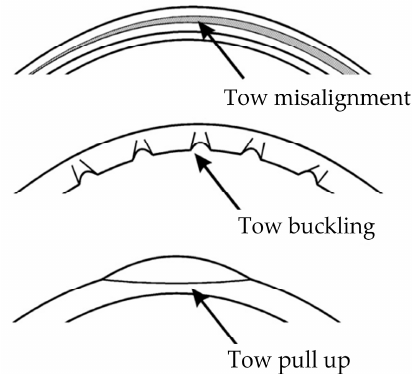
Figure 8. Overview of tow steering defects leading to out-of-plane fiber waviness [52]. Reprinted from Composites: Part B, Vol. 43, The engineering aspects of automated prepreg layup: History, present and future, page 1005, (2012), with permission from Elsevier.